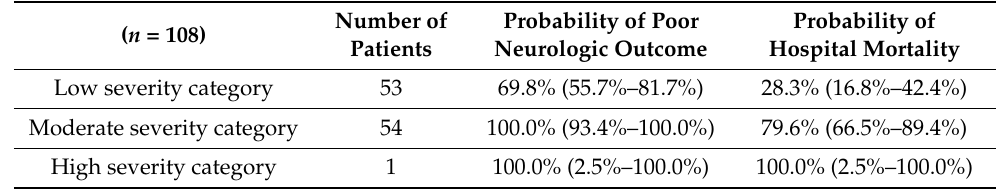
Figure 4. Sensitivity and specificity of using the rCAST score to predict poor neurological outcomes at day 28 in out-of-hospital cardiac arrest patients. There was decreased sensitivity and increased specificity to using a higher rCAST score as a cut point to predict the poor neurologic outcomes. The predicted probabilities of poor neurologic outcomes on day 28 were 69.8%, 100.0%, and 100.0% with low, moderate, and high severity according to the rCAST score, and the predicted probabilities of mortality at day 28 were 28.3%, 79.6%, and 100.0%, respectively (Table 2). Table 2. Predictive probability of poor neurologic outcomes or mortality at day 28 according to the rCAST severity category.